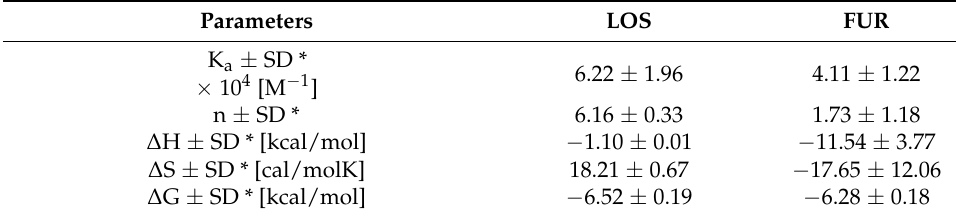
Table 1. Drugs–albumin interaction parameters. T = 298